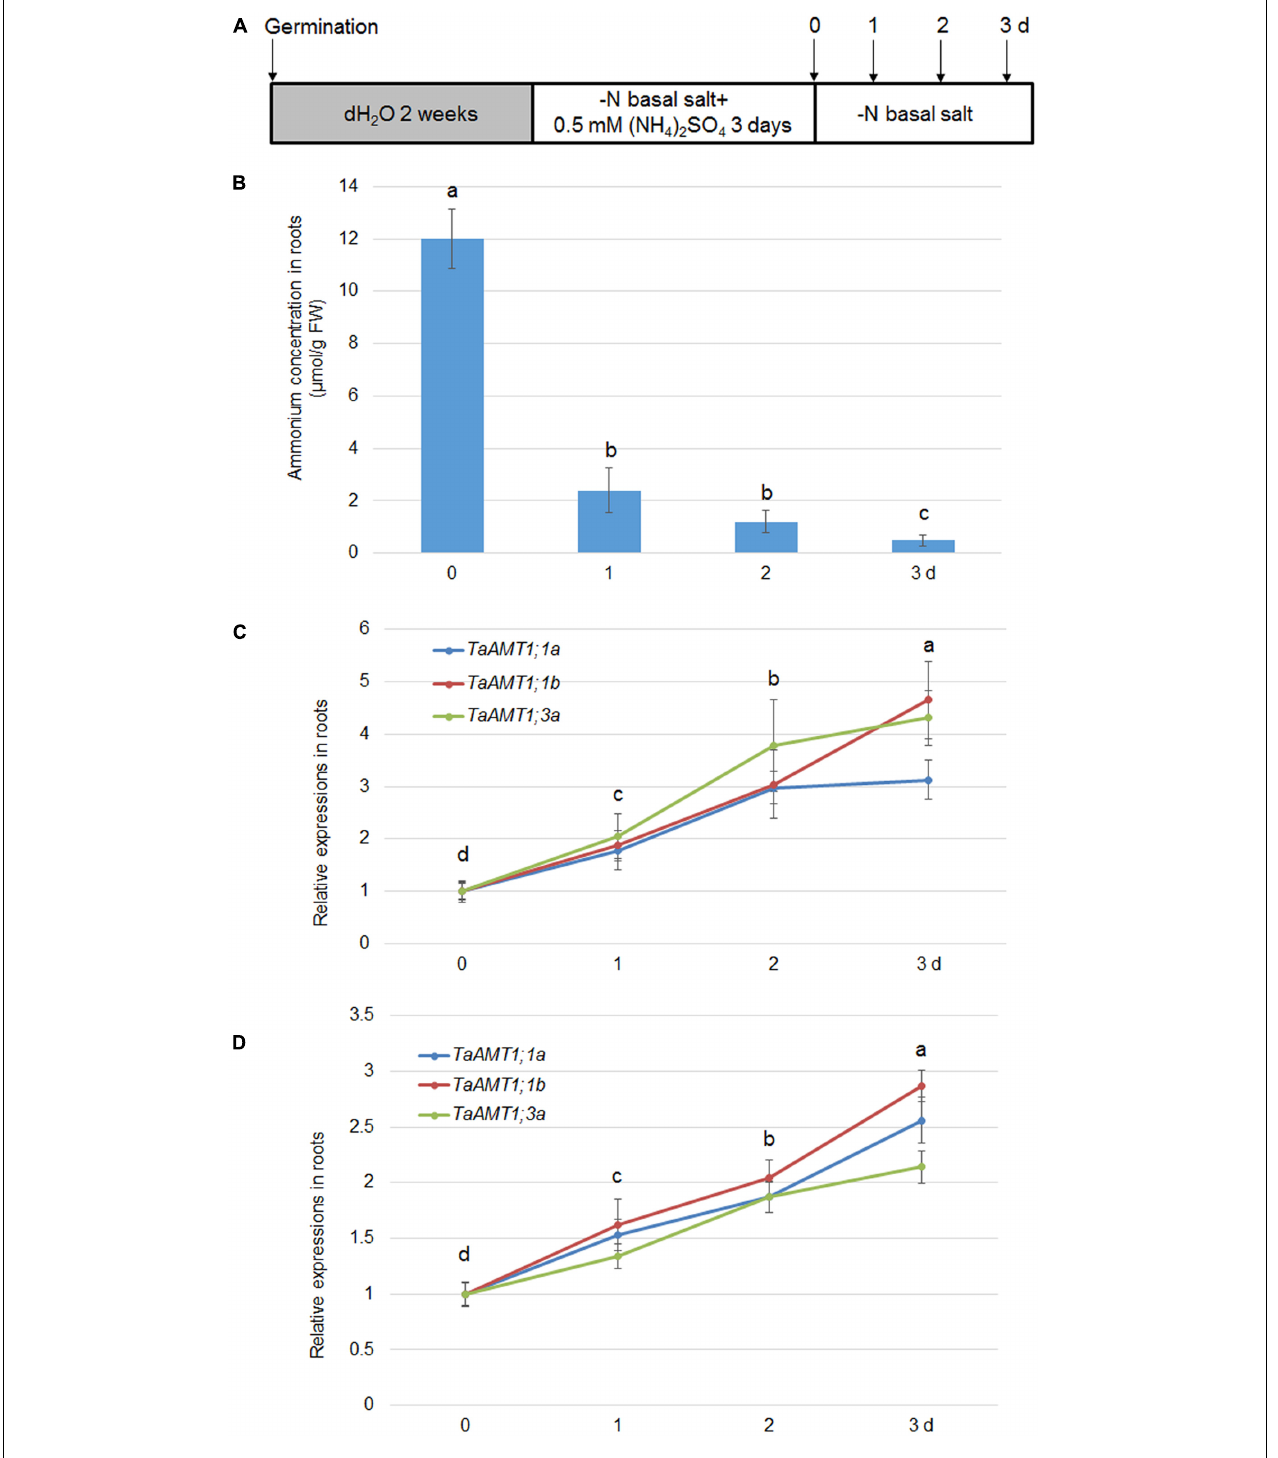
FIGURE 6 | Effect of N-deprivation on TaAMT1;1 gene expressions. For testing N-deprivation dependent gene expressions, the plants were grown as described in the section “Materials and Methods” (A) . Endogenous NH + 4 levels measured in the roots of 17-day-old plants. Data represent means ± SE ( n = 3) (B) . The N-deficiency dependent expression of TaAMT1;1a , TaAMT1;1b , and TaAMT1;3a were analyzed in the roots (C) and leave (D) samples. Significant differences at P < 0.05 level are indicated by different letters.